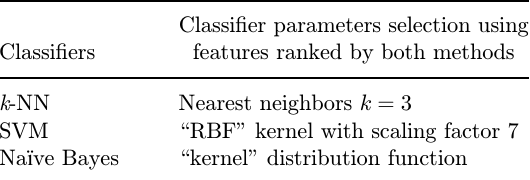
Table 3. Parameters con¯guration for di®erent classi¯ers.